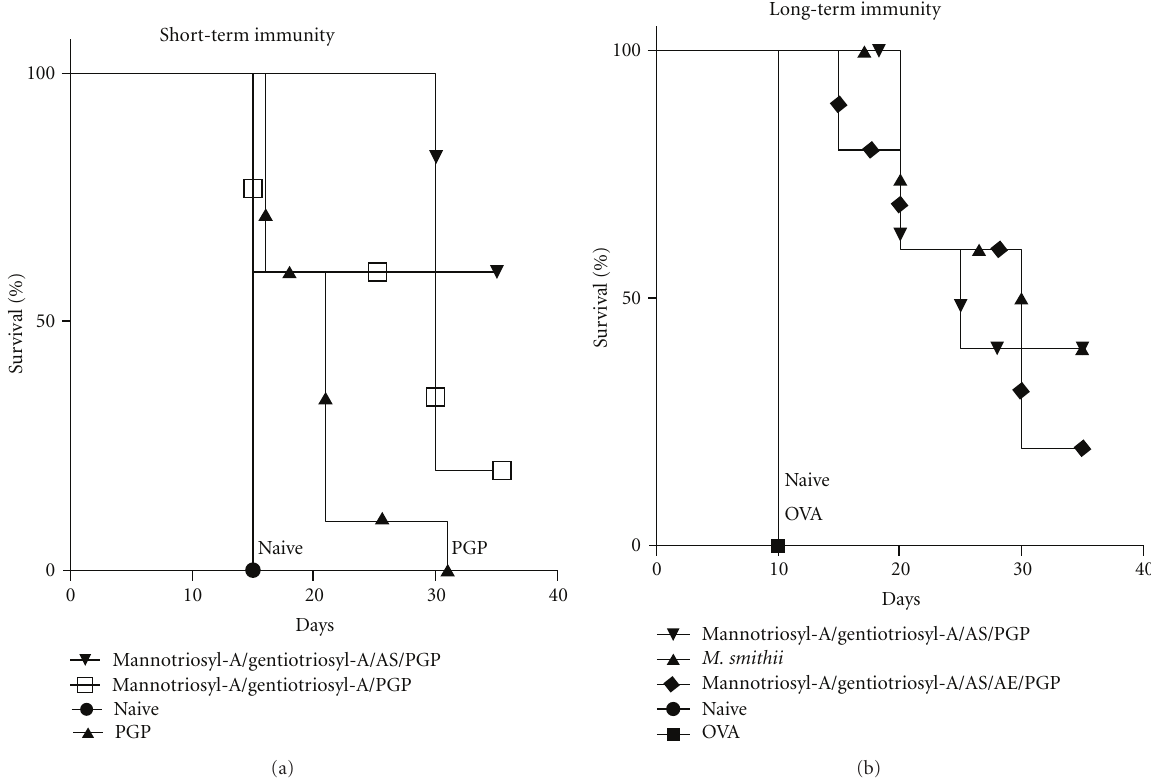
Figure 9: Protection of mice immunized with archaeosomes of various lipid compositions in a solid tumour model. Groups ( n = 5) of unvaccinated mice (naive) or mice vaccinated with various OVA-archaeosomes were challenged with a subcutaneous injection of EG.7 cells (time zero) either 4.5 weeks (panel (a)) or 14 weeks (panel (b)) following their last